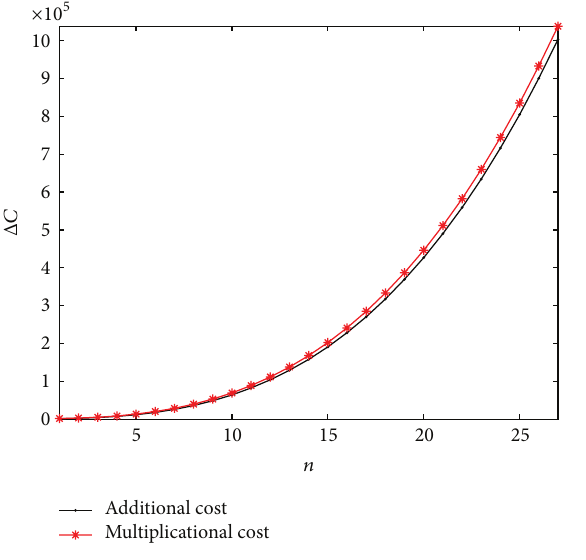
Figure 1: Error of computational cost.